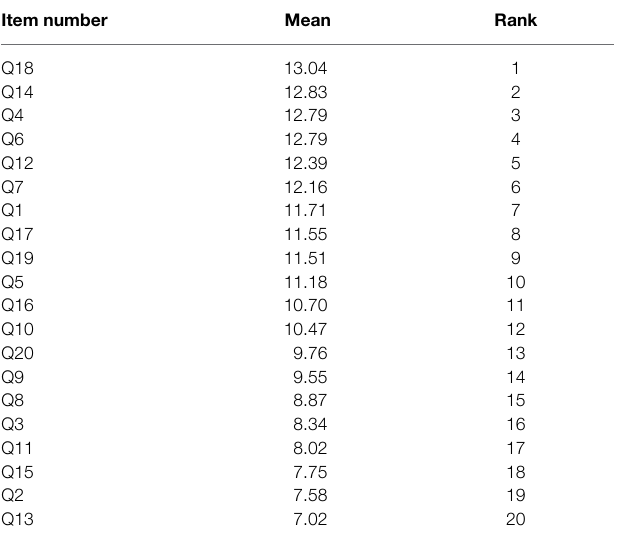
TABLE 4 | The ranks of pedagogy-related emotional scaffolding strategies in the teachers’ views.